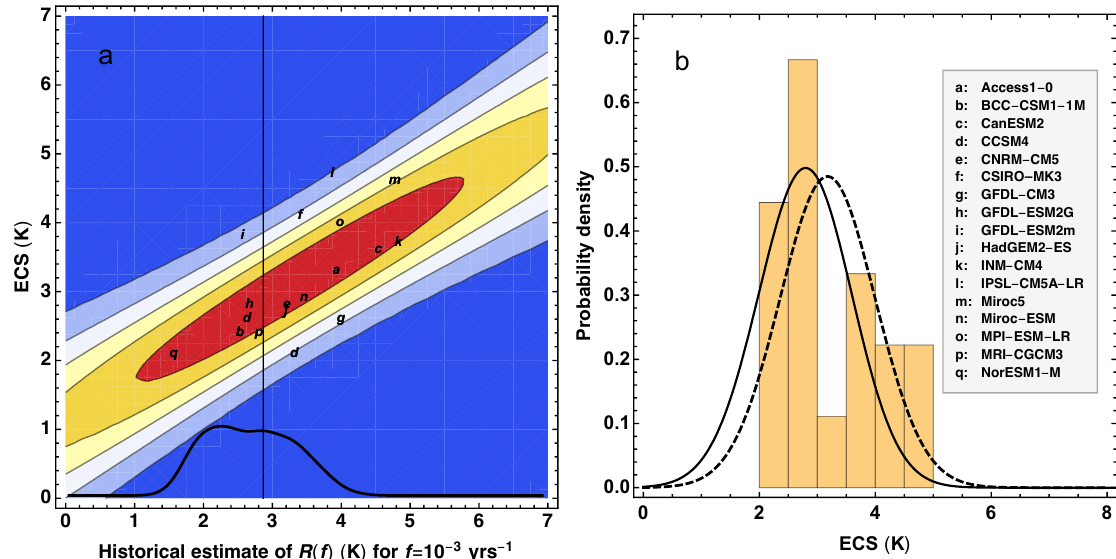
Figure 3. ( a ) The letters (see the legend inserted in panel ( b )) show the Gregory estimate of ECS versus R(f)m evaluated at f = 10 − 3 y − 1 for each model in the ensemble. The contour plot shows the conditional probability density function (PDF) p ( ECS | R ) . The vertical black line is R = 2.9 K, which is obtained from the parameters β = 0.66 and µ = 11.9 × 10 − 3 y − 1 estimated from the instrumental temperature record using the Hansen forcing. The thick, black curve is the estimated PDF of R ( f ) . ( b ) The full curve shows the PDF for ECS computed from Equation (14), where p ( R ) is the PDF shown in ( a ). The histogram is the distribution of ECS in the model ensemble, and the dotted curve is a Gaussian fit to the histogram.